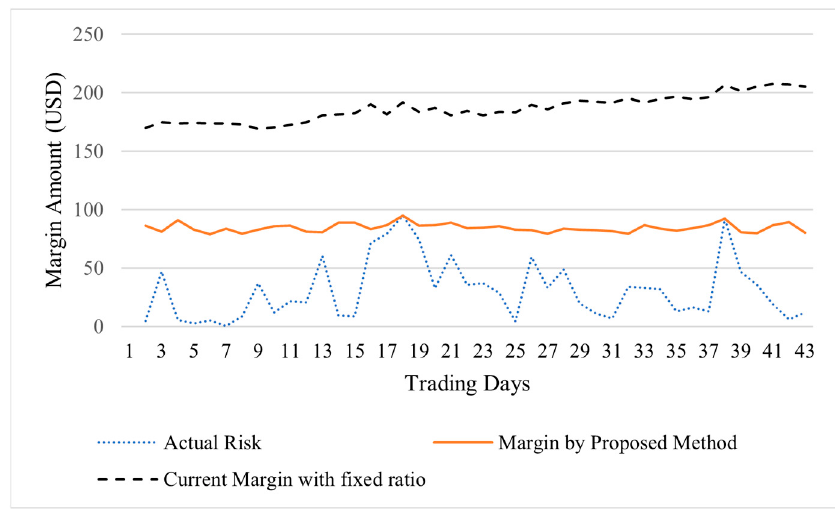
Figure 7. Comparison of the absolute values of margin and actual loss amounts.